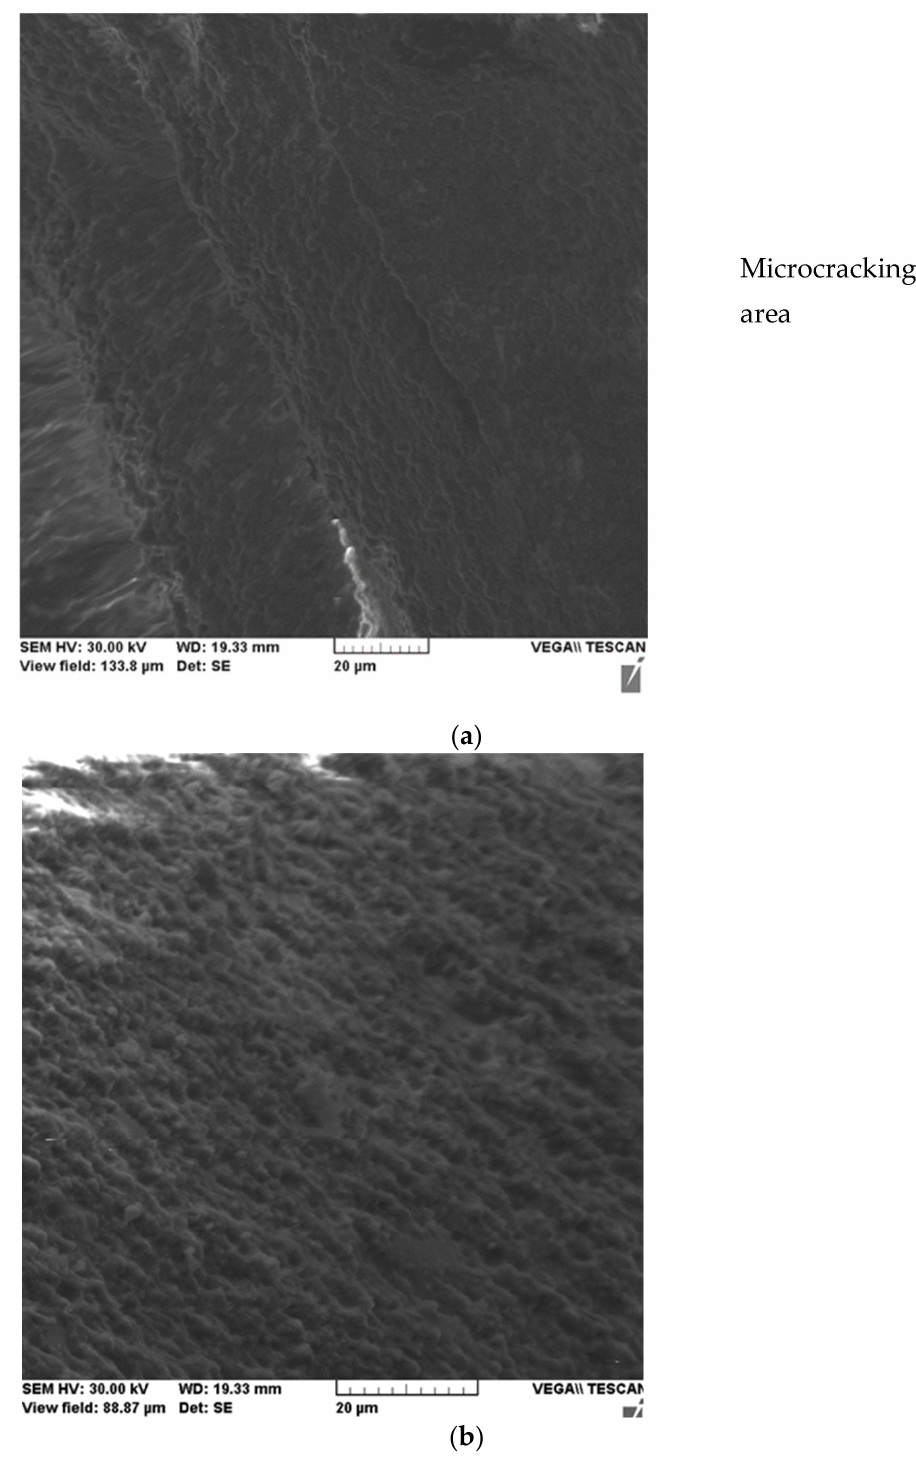
Figure 4. SEM microscopy of the Filtek Supreme XT-4 sample with propagation of a microcrack between nanometer particle clusters ( a ) and an unaffected area ( b